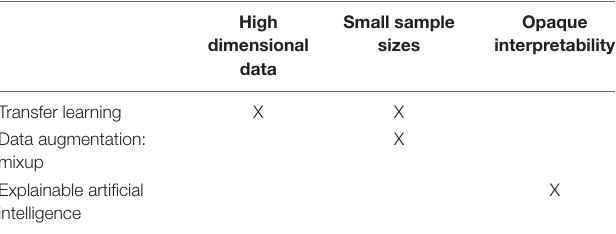
TABLE 1 | Challenges for deep learning on fMRI data and proposed, emerging